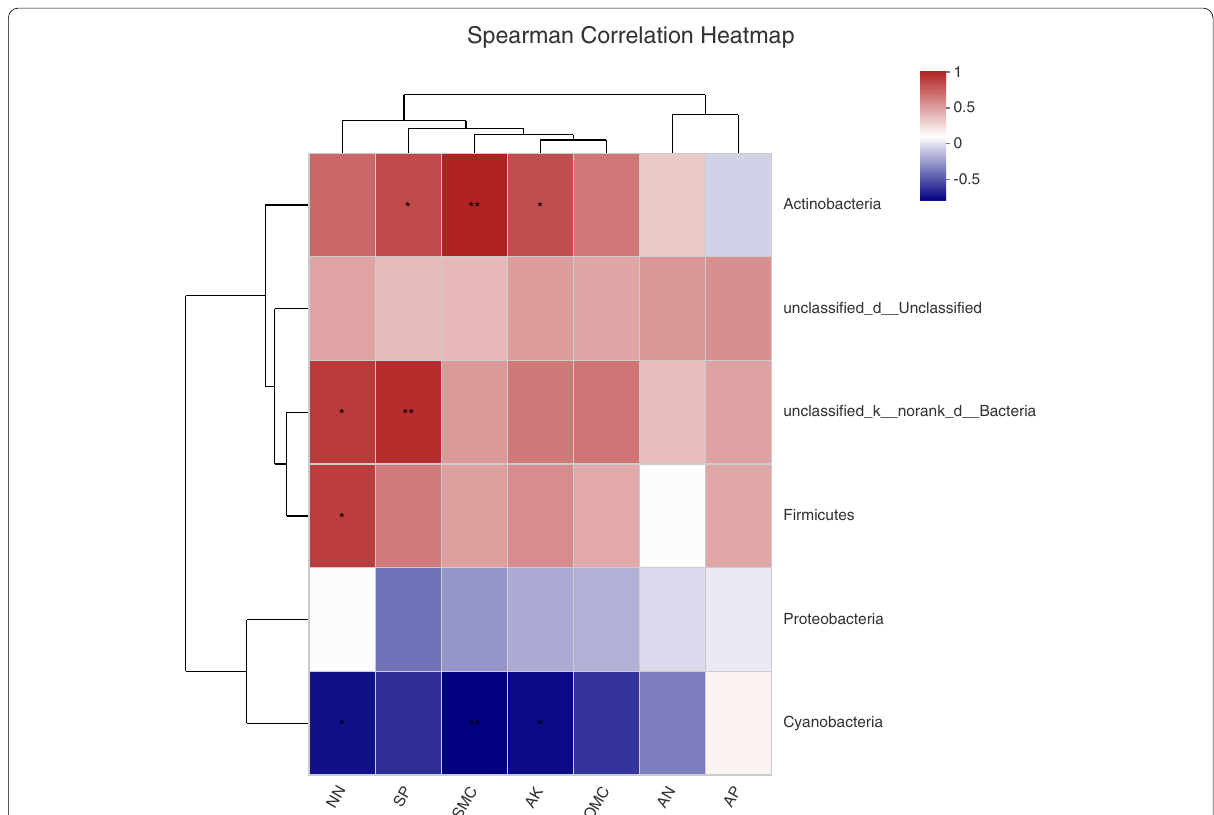
Fig. 9 Spearman correlation heatmap between bacteria at the phylum level and physical and chemical properties. Notes: NN, SP, SMC, AK, OMC, AN, and AP are the same as in Fig. 1. * P